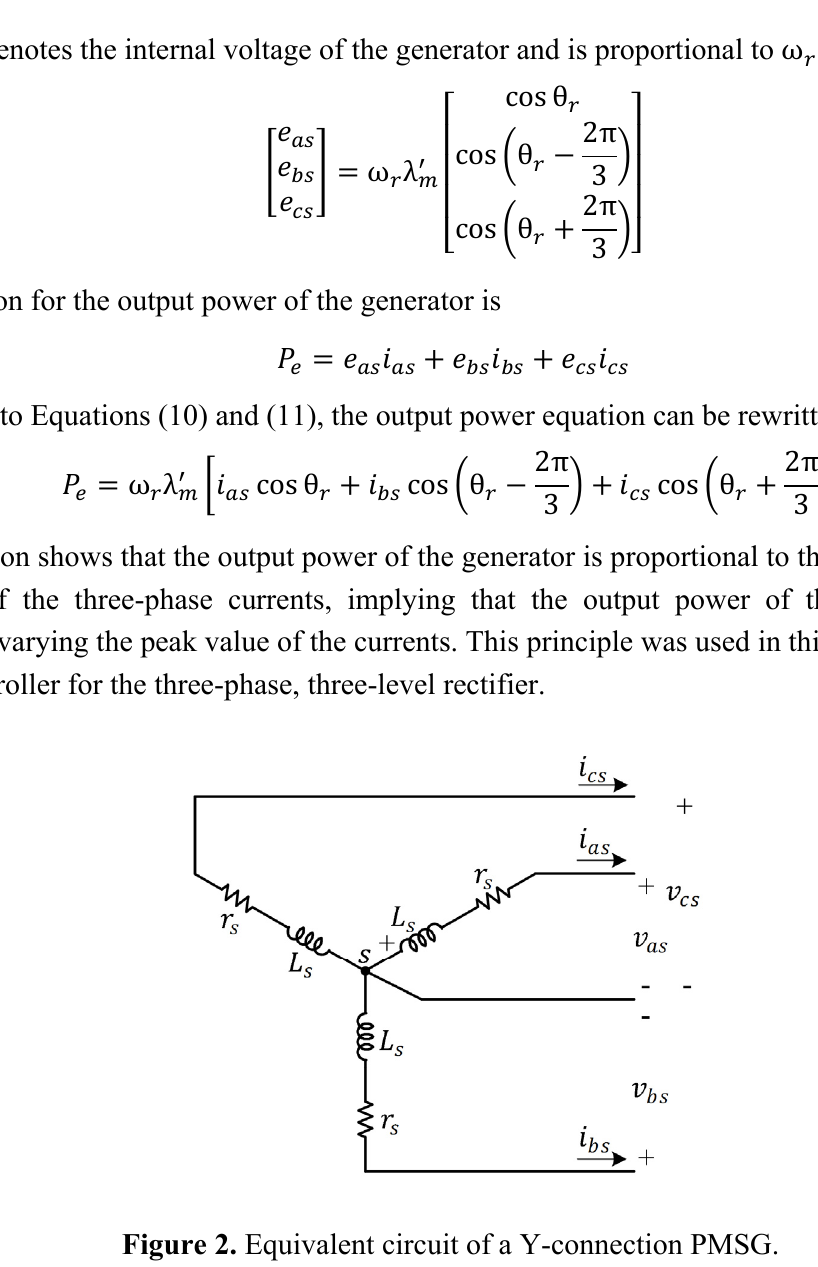
Figure 2. Equivalent circuit of a Y-connection